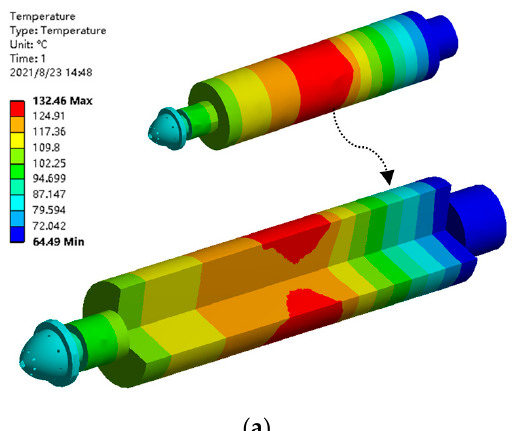
Table 5. Various loss values of high-speed motor by